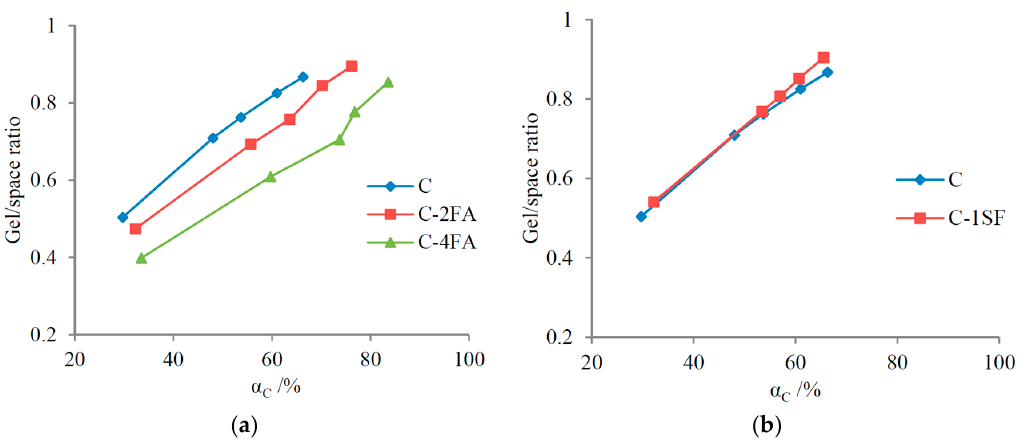
Figure 8. Relationship between gel/space ratio and cement reaction degree in binary systems: ( a ) FA; and ( b ) SF.